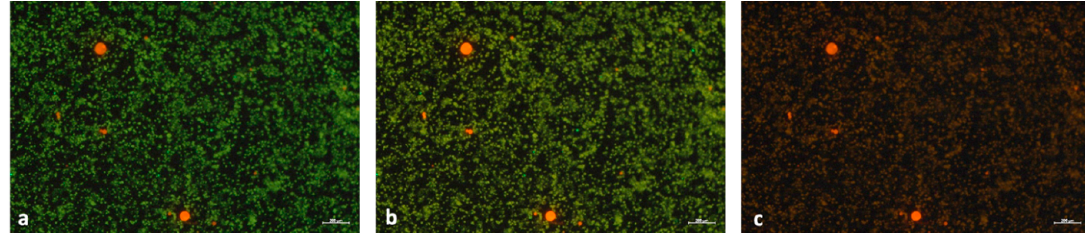
Figure 6. Images of the filter taken with the fluorescence microscope under blue light ( a ), blue and green lights ( b ) and green light ( c ). The red dots represent the PVC-PtOEP MPs ingested from the mussel and extracted with the density gradient. Scale bar 200 µm.